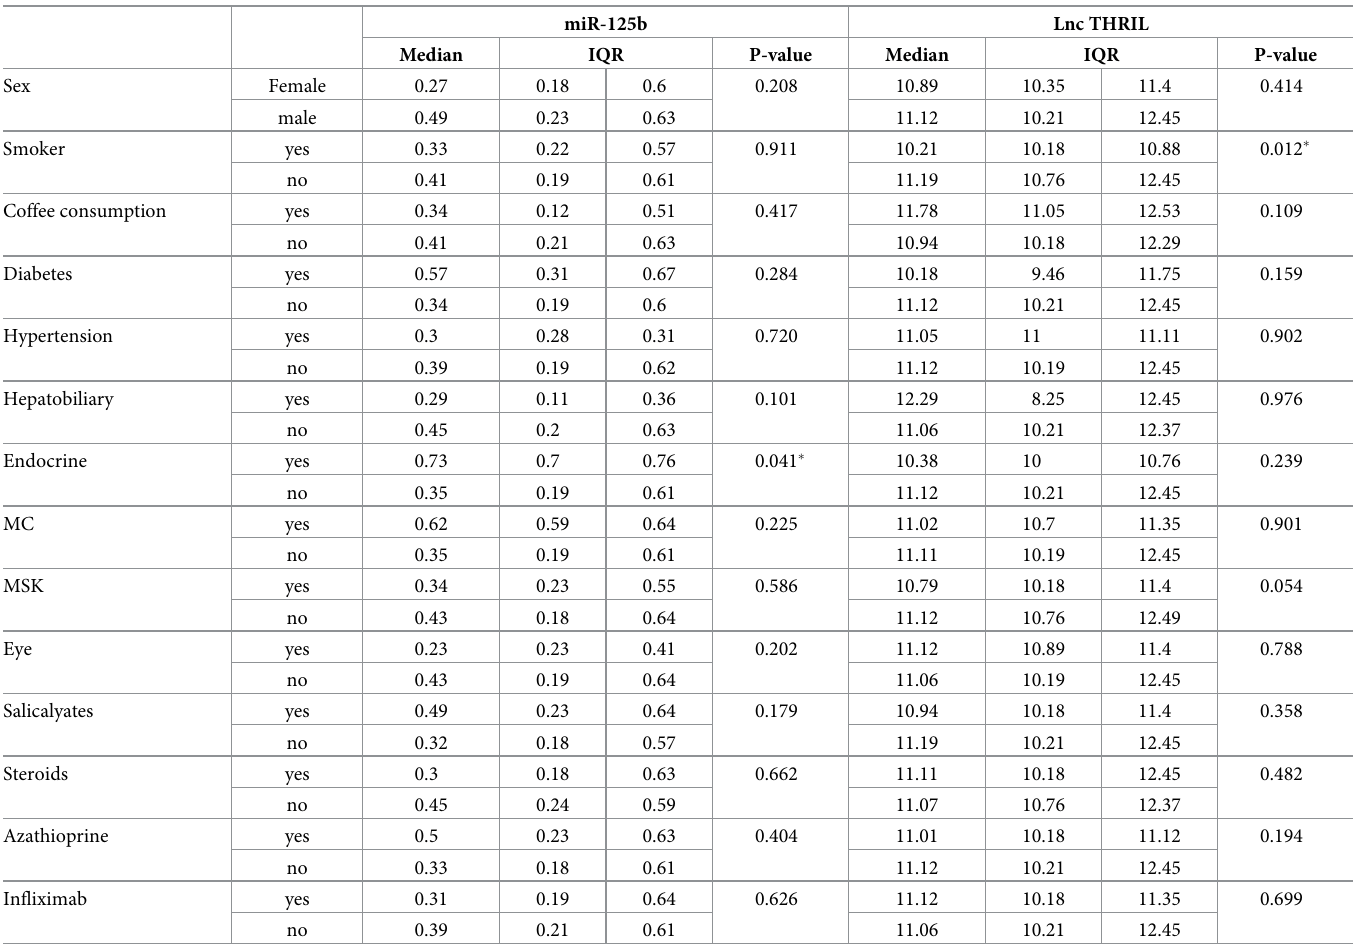
Table 3. Relations between Lnc THRIL and MiR-125b and clinical data in UC